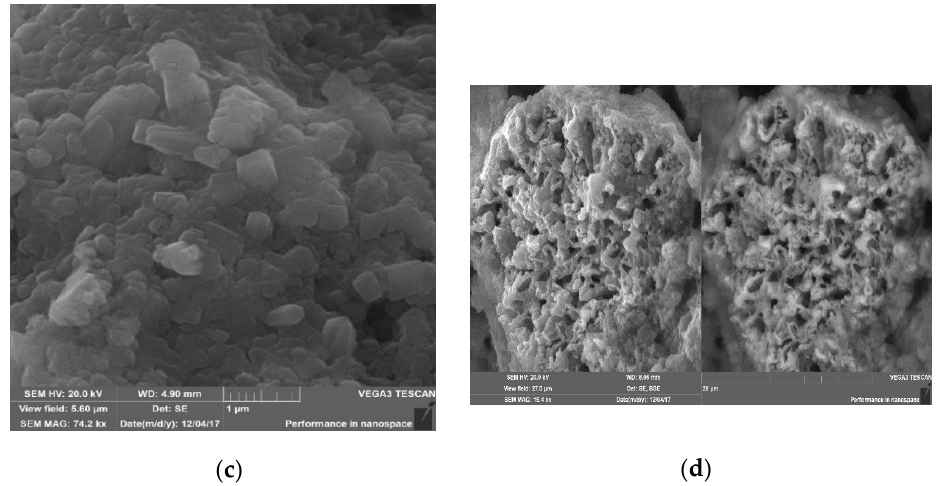
Figure 9. Results of studying the microstructure of the carbonised samples: ( a , b )—general view; ( c )—CaCO 3 crystals; ( d )—products of the β-C 2 S hydration.